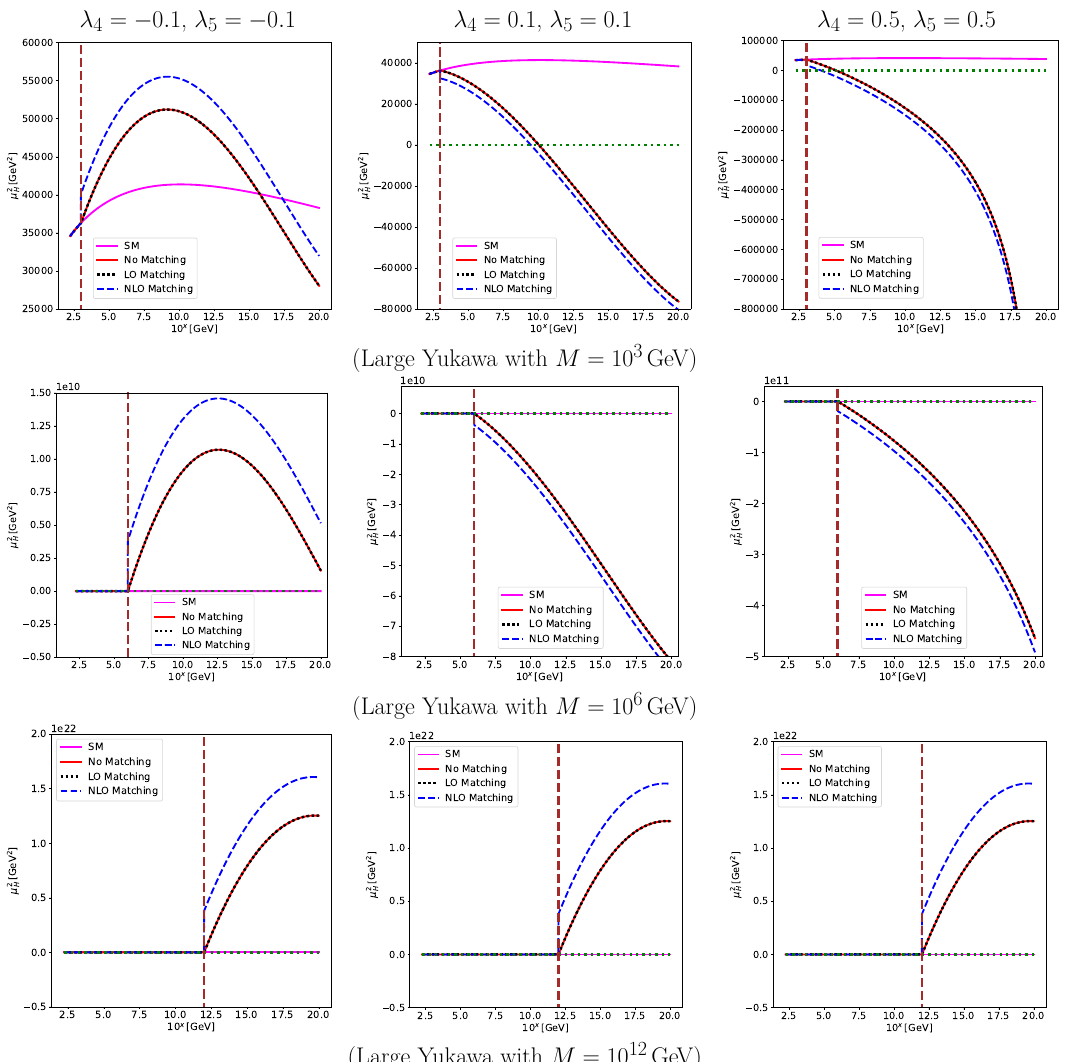
Figure 8 . Same as figure 7 but for the large Yukawa case in table